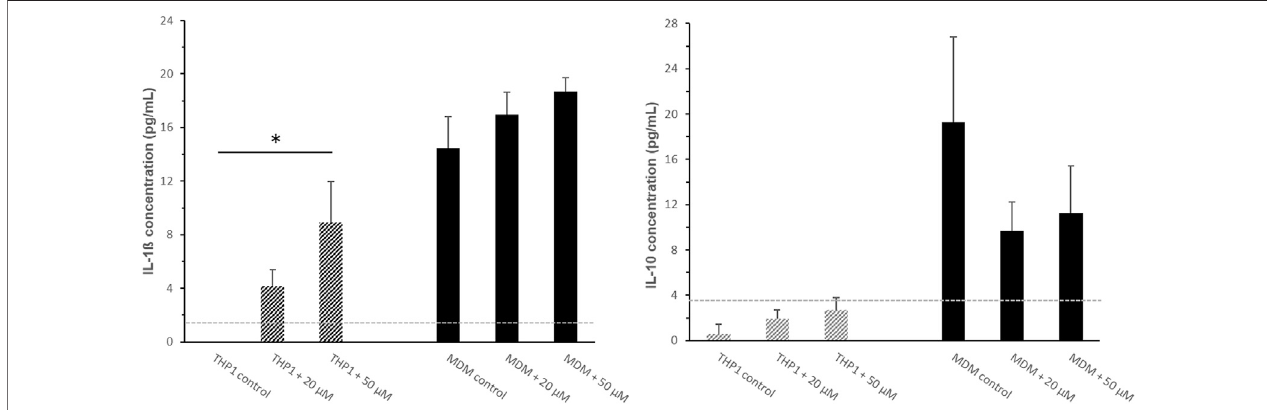
FIGURE 5 | Cytokine secretion of monocytic THP-1 cells and monocyte-derived macrophages (MDMs) after 24 h SPION incubation. The pro-in fl ammatory cytokine IL-1 β and the anti-in fl ammatory cytokine IL-10 were analyzed in cell culture supernatants by standard ELISA protocol. The light grey dotted line represents the detection limit. Signi fi cance: student`s t -Test. * p ≤ 0.05. n = 3.